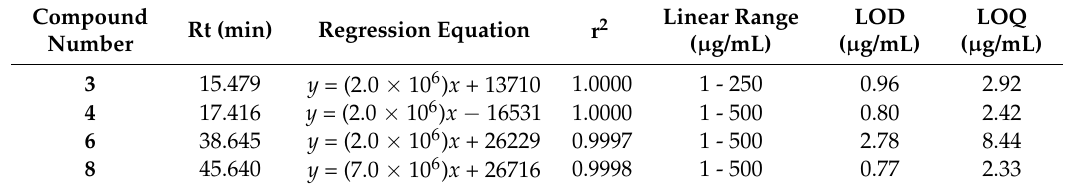
Table 6. Linear relation between peak area and concentration ( n =